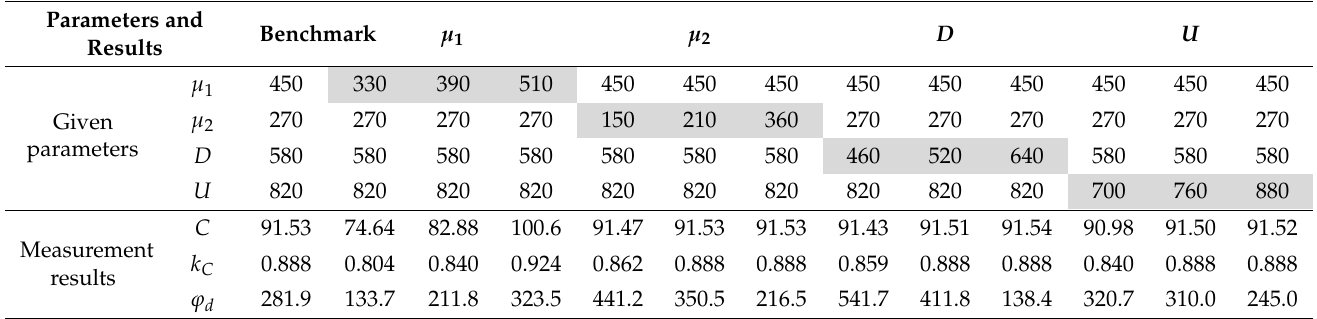
Table 6. Results of given parameters for sensitivity analysis. (Design parameters: λ a = 0.06, n = 3, m = 2, N =